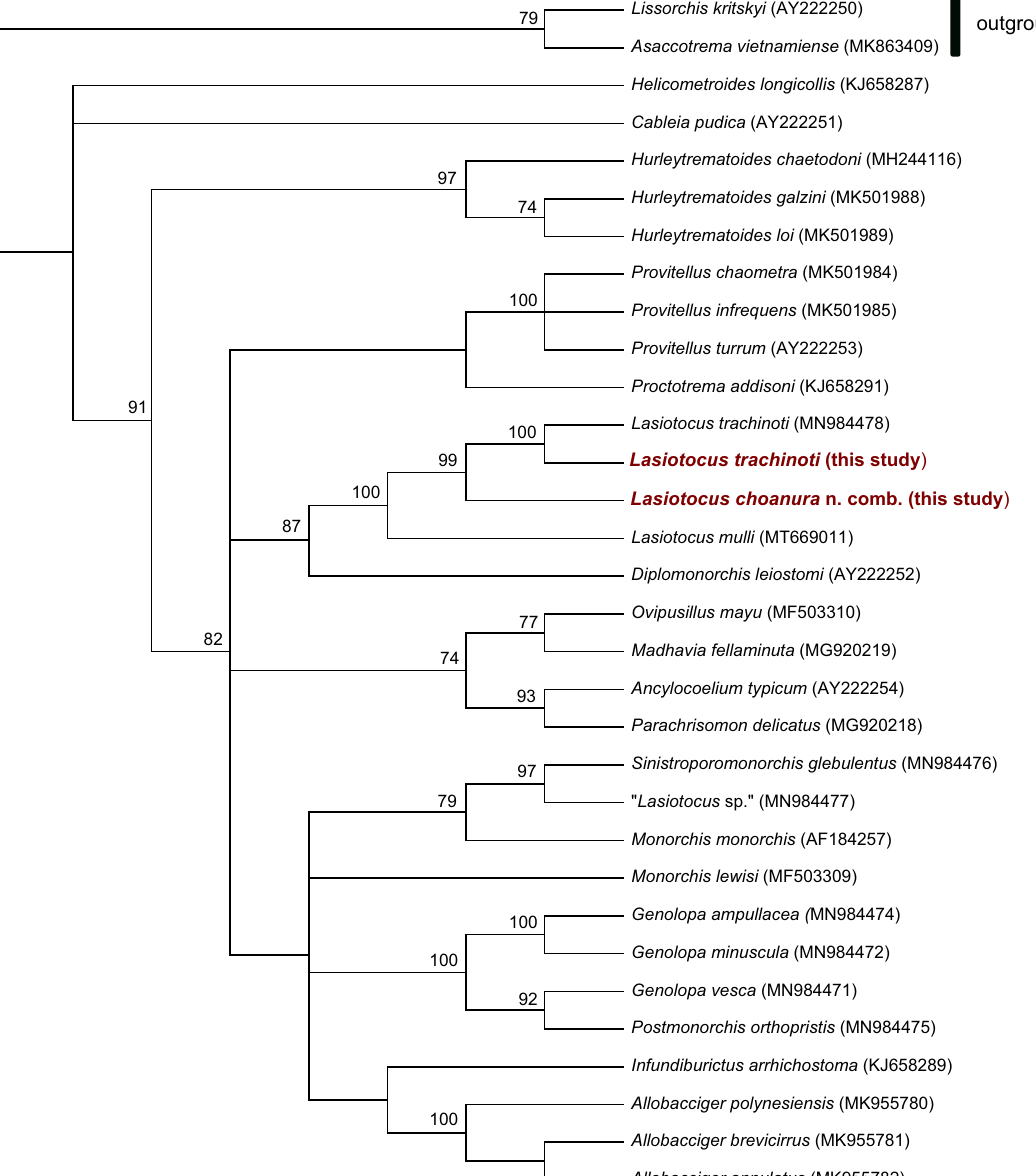
Figure 6. Phylogenetic relationships among monorchiid taxa based on maximum parsimony analysis of an 848-base pair alignment of partial large subunit (28S) ribosomal RNA gene sequences from the current study (in red and bolded) and from GenBank. Bootstrap support values are shown above the nodes (values < 70% are not shown and branches with < 50% support are